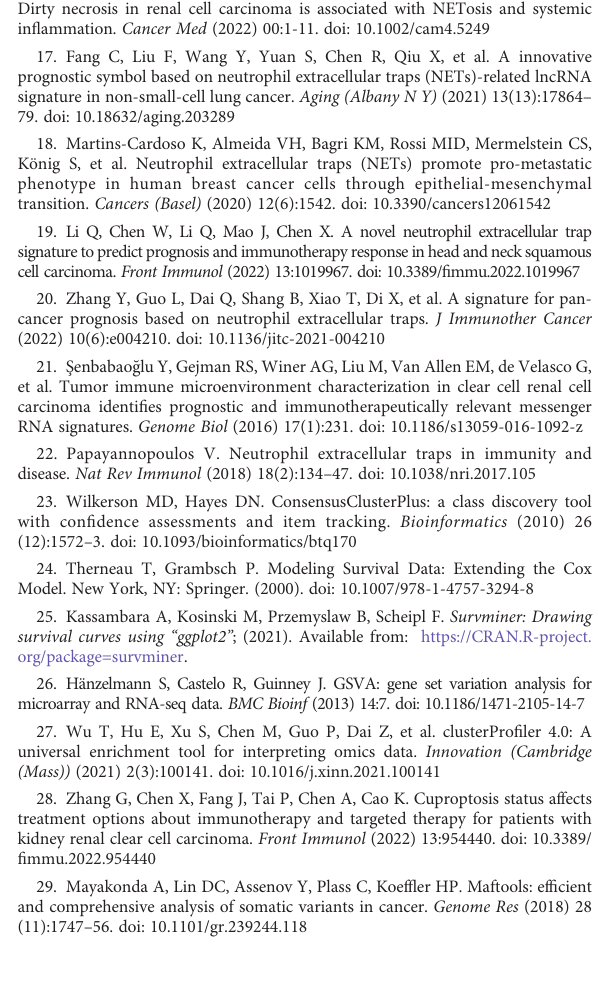
SUPPLEMENTARY TABLE 1 The differential expression results of NET-related genes in TCGA- KIRC dataset.